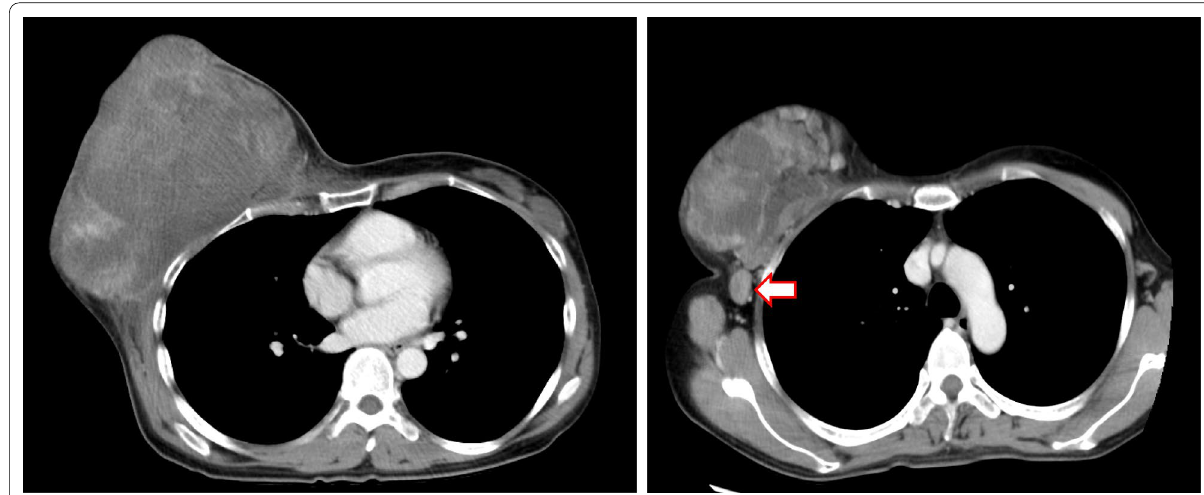
Fig. 2 Computed tomography showed a 20 cm heterogeneous mass in the right breast and axillary and supraclavicular lymph nodes swelling